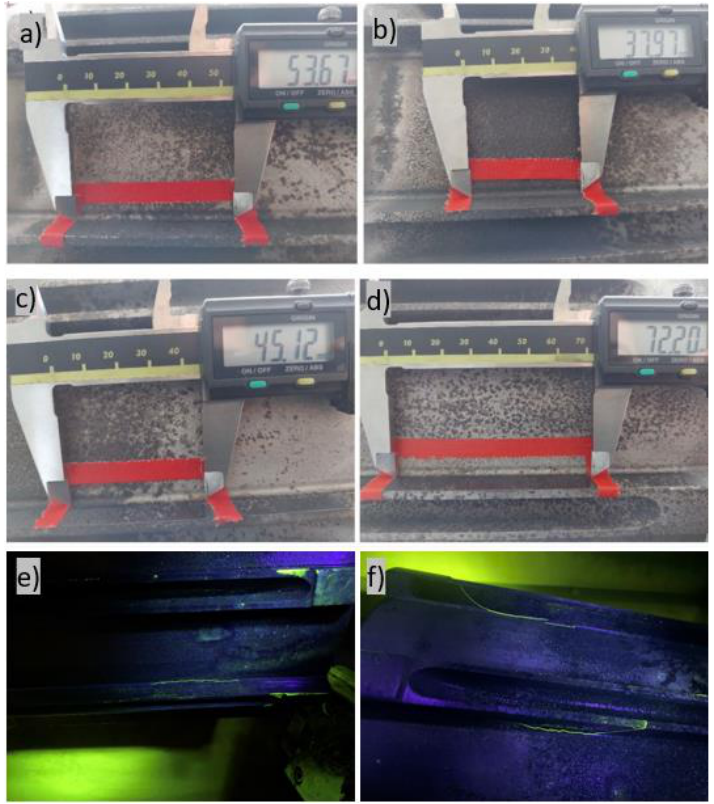
Figure 2. ATT cracks: ( a ) 25,000 cycles; ( b ) 17,000 cycles; ( c ) 36,000 cycles; ( d ) 17,000 cycles; ( e , f ) ATT cracks in the rib area visualized using a non-destructive technique.